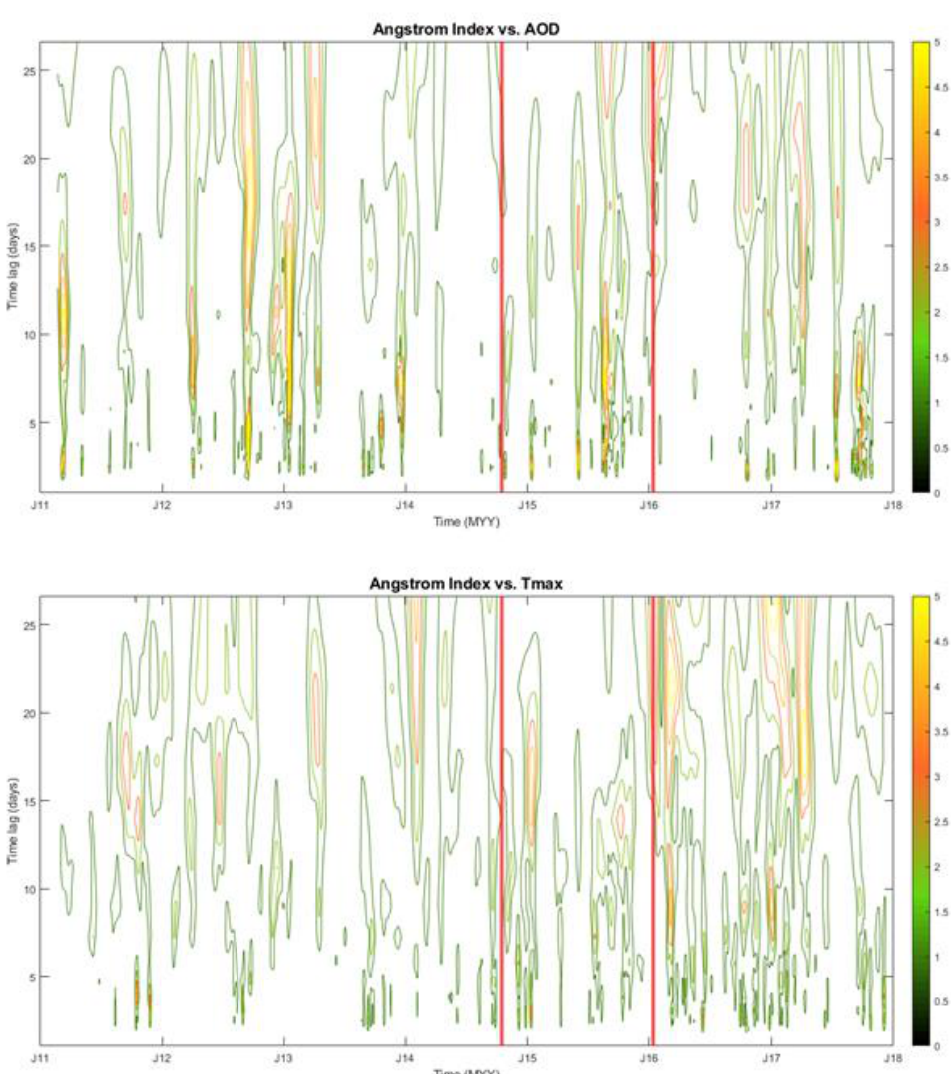
Figure A3. Local cross-correlation wavelet spectra for Ångström index data versus Tmax ( top ) and AOD ( bottom ) records. To examine dates of cross-correlations, we were looking only at x-axis positions of vertical lines on LCWTS graphs. Red vertical lines mark the date of the dust storm. The color scale codes the values of wavelet cross-correlation coefficients |𝐶𝐸 𝑥,𝑦 (𝑎, 𝑏)| . Table A1. Terms used for each of the health outcomes of interest in the study.